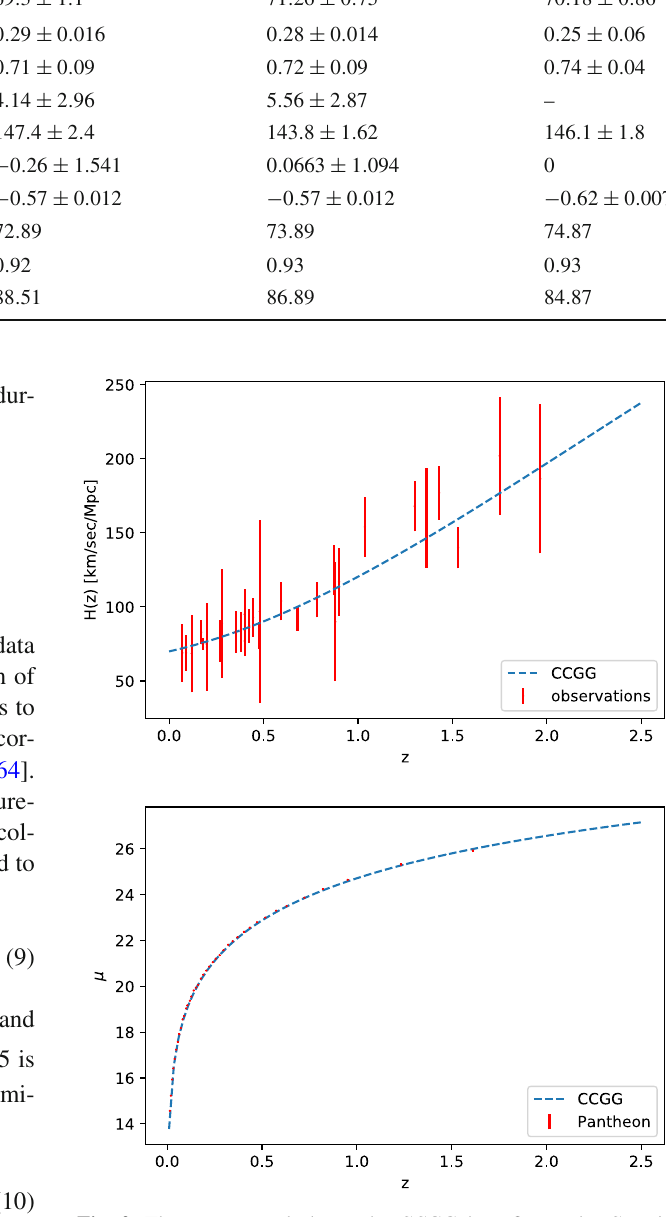
Fig. 2 The upper panel shows the CCGG best fit vs. the Cosmic Chronometers dataset. The lower panel shows the the CCGG best fit vs. 40 uncorrelated points of the Type Ia supernova dataset. The dataset is presented in red, and the best fit is presented in blue